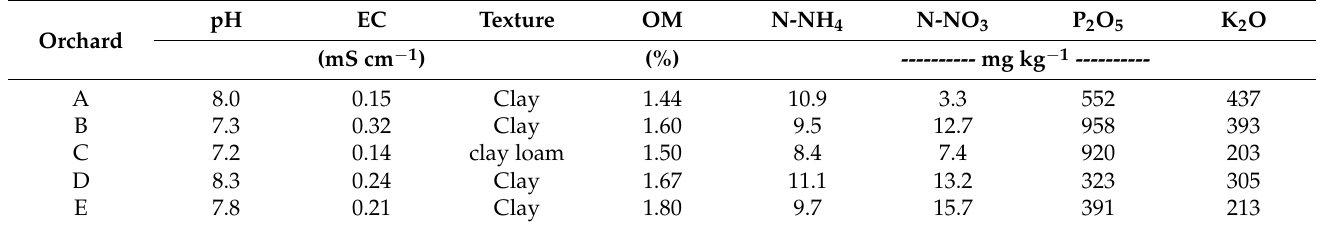
Table 1. Main soil characteristics according to soil analysis 2018.